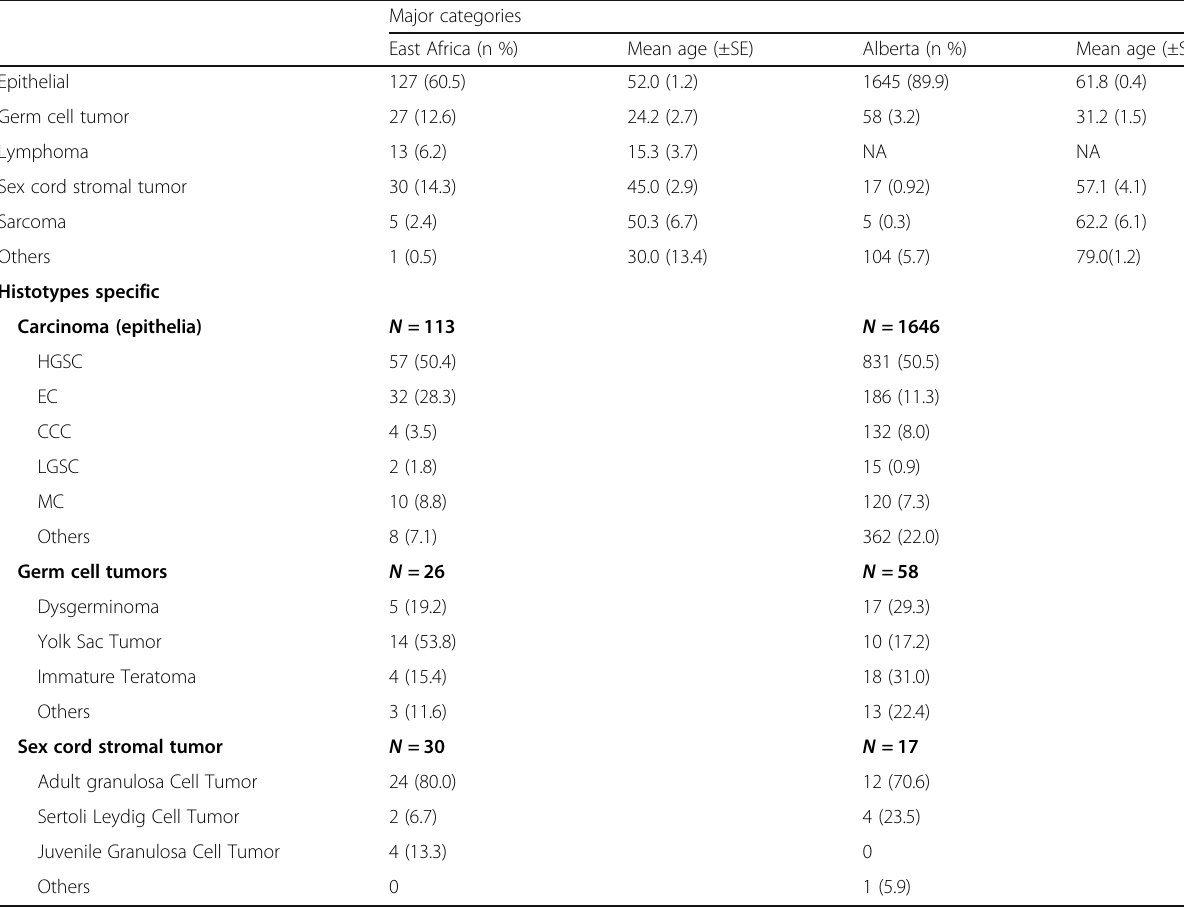
Table 4 Patterns of ovarian cancer tumor types in Tanzania compared with Alberta, Canada Major